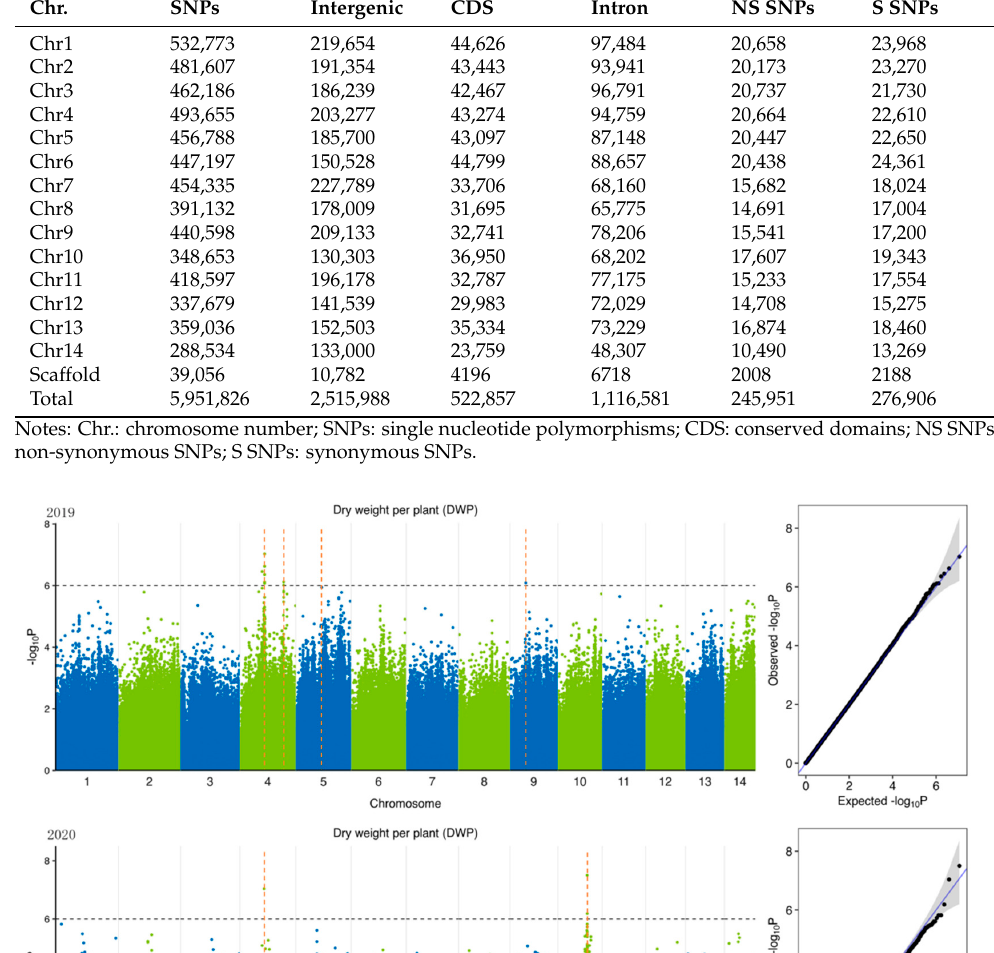
Figure 4. Manhattan plots of GWAS results for fresh weight per plant (FWP) in 2019 and 2020. Notes: Blue and green dots represented SNP (single nucleotide polymorphism) sites on chromo- somes, respectively. When the value of − log 10 p was above 6 (gray line), the selected SNP site with significant aboriginality. Orange dotted lines represented the location of SNP loci.